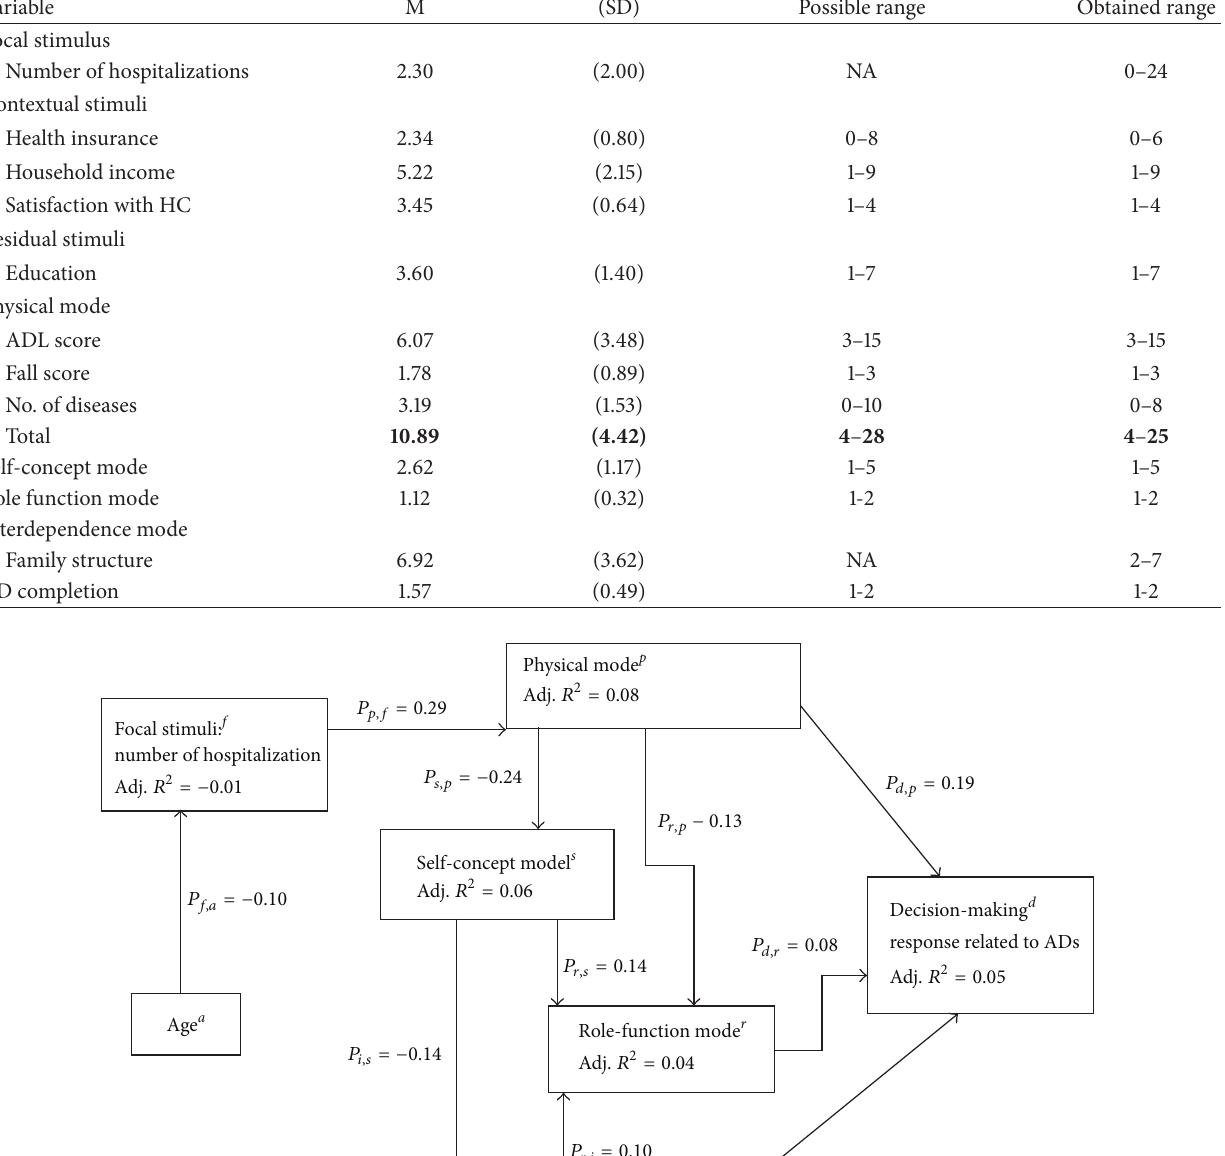
Table 2: Descriptive statistics for variables in the model.